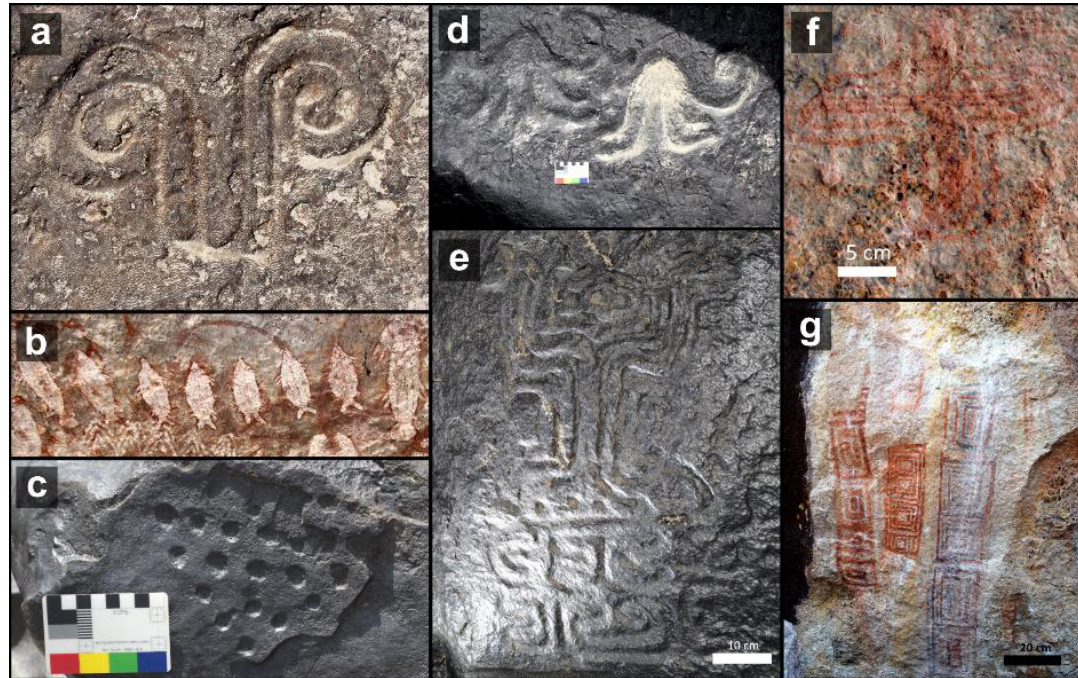
Figure 2. Examples of common Middle Orinoco rock art motifs. ( a ) A single-ended double scroll, Picture Upper (Scroll2), ( b ) Fish in profile with and without internal subdivisions, Cerro Gavilán II, (Fish1 and Fish2), ( c ) Dots arranged in a geometric shape, Yavarivén II, (Dots1), ( d ) Quadrupeds in profile, Raudal Zamuro, (Animal2), ( e ) Meandering composition of different motifs, including scrolls, spirals, and geometrics. Common enough to warrant a separate category, Yavarivén II, (Composite1), ( f ) Concentric cross motif, Cerro Pintado 8, (Cross1), ( g ) Internally subdivided regular geometric shapes and a chained variant, Cerro Dagua II, (Geometric1 and Chain3).